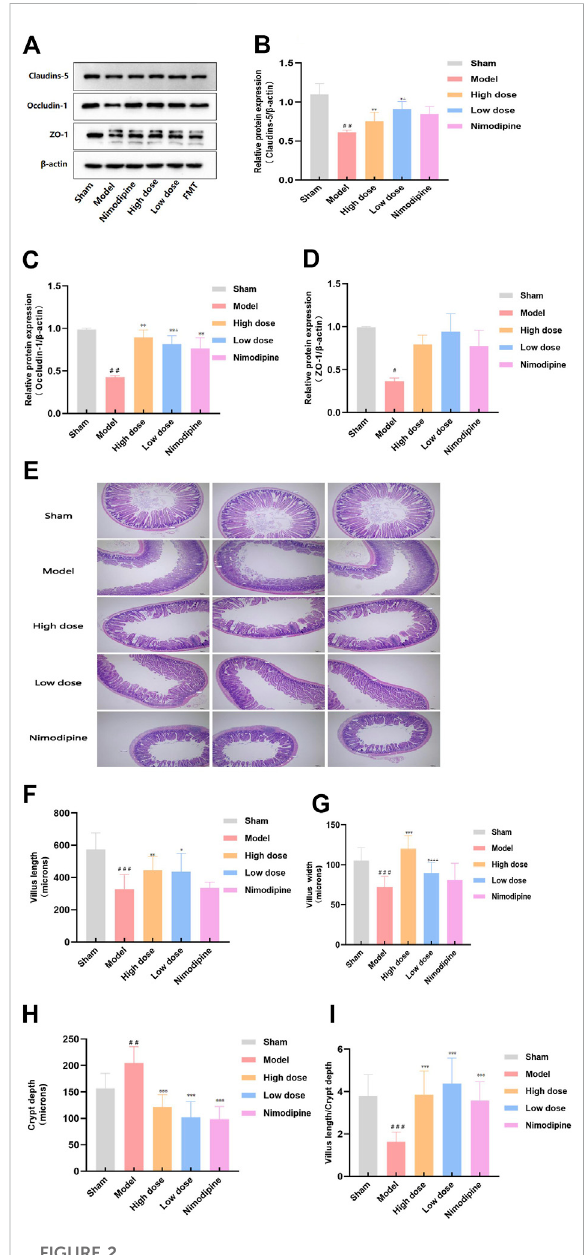
FIGURE 2 ZHTC improves intestinal barrier damage in MCAO